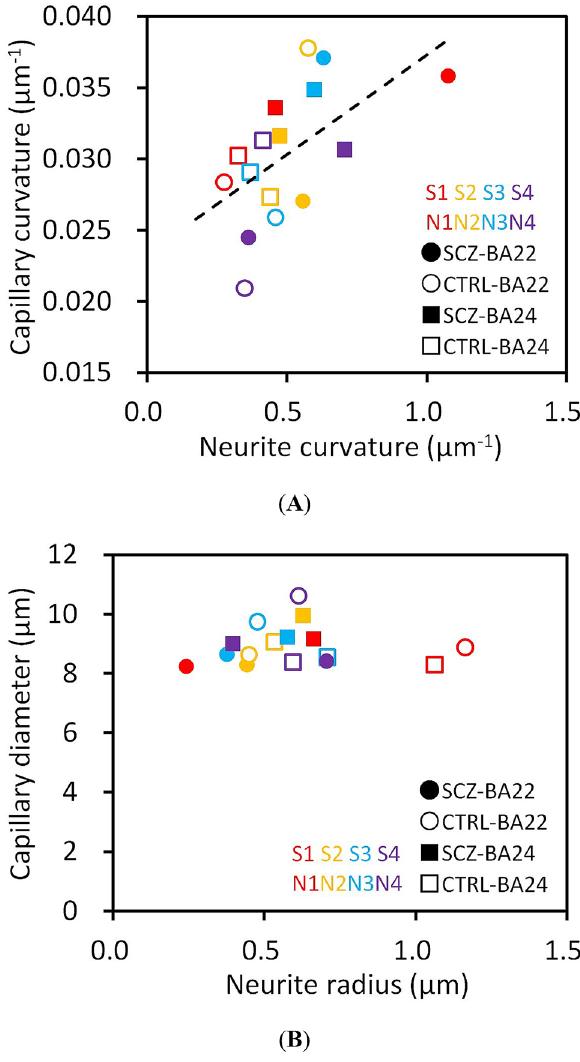
Figure 4. ( A ) Relationship between mean capillary curvature and mean neurite curvature of the BA22 or BA24 area of each case. The dashed line indicates a linear regression. Schizophrenia cases S1–S4 and controls N1–N4 are color-coded. ( B ) Relationship between mean capillary diameter and mean neurite thickness radius. Cases are color-coded as in ( A